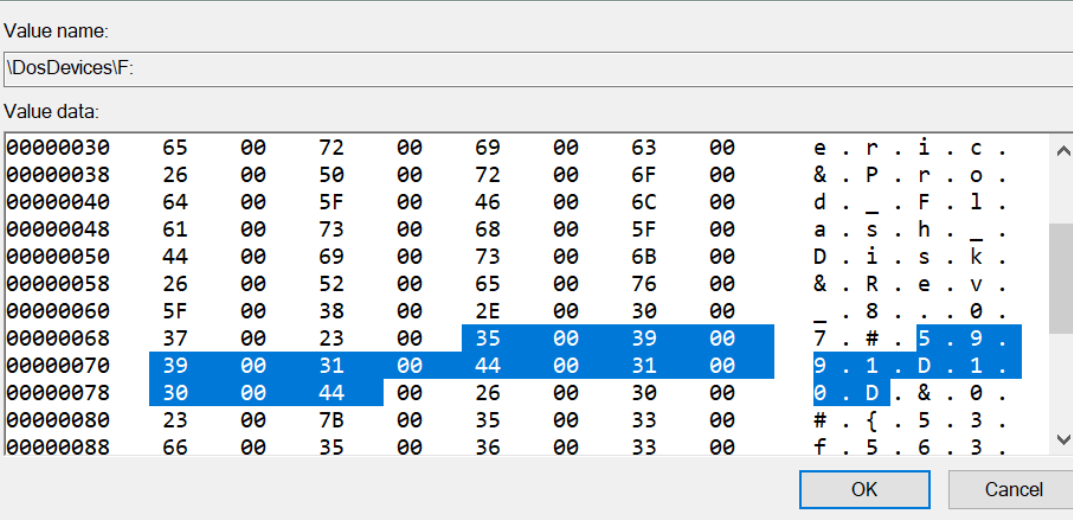
Figure 17. USB device